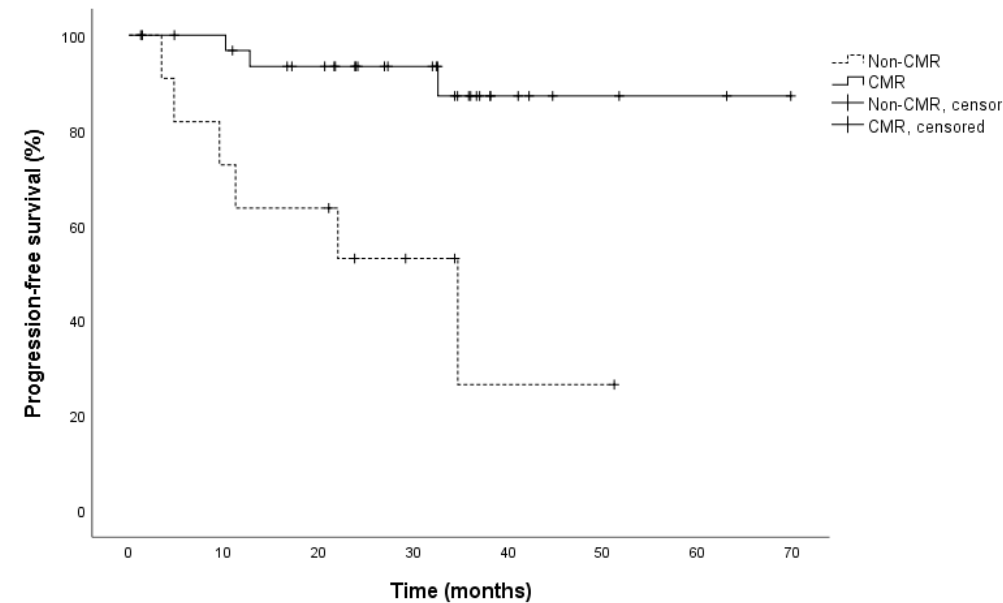
Figure 2. Kaplan–Meier analysis for progression free survival (PFS) in CMR ( n = 32) and non-CMR patients ( n = 13) (hazard ratio: 0.127; 95% CI: 0.032–0.511). Median PFS in non-CMR patients was 34.7 months (95% CI: 9.6–59.8), median PFS for CMR patients was not reached (log-rank: p = 0.001). CMR, complete metabolic response. CI, confidence interval. PFS, progression-free survival. Table 3. Univariable Cox regression analysis for progression-free